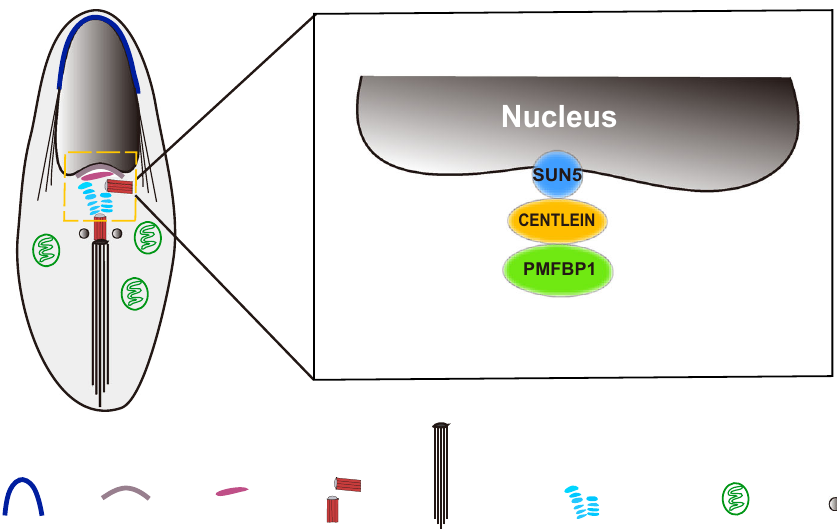
Fig. 8 A proposed model for the role of CENTLEIN in integration of sperm head to the tail. CENTLEIN works as a linker between SUN5 and PMFBP1 to maintain the integrity of